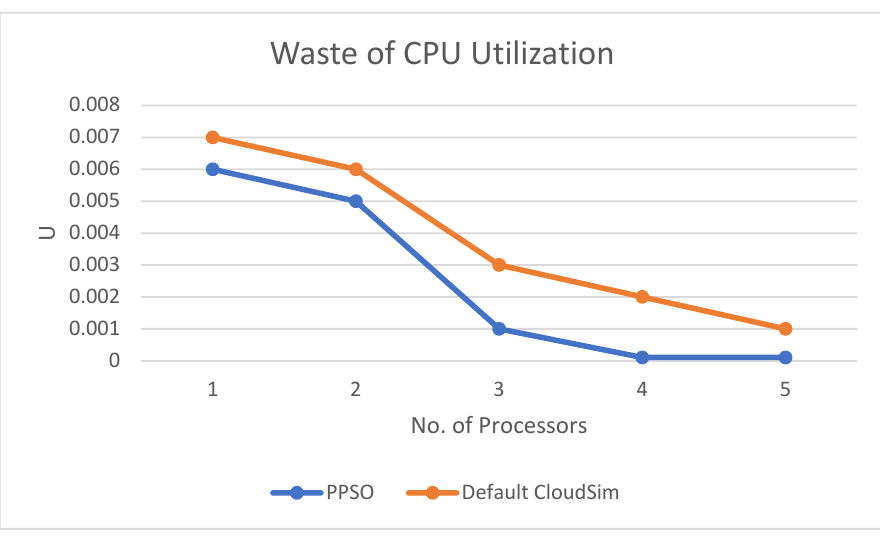
Figure 7. The relation between U and number of processors.